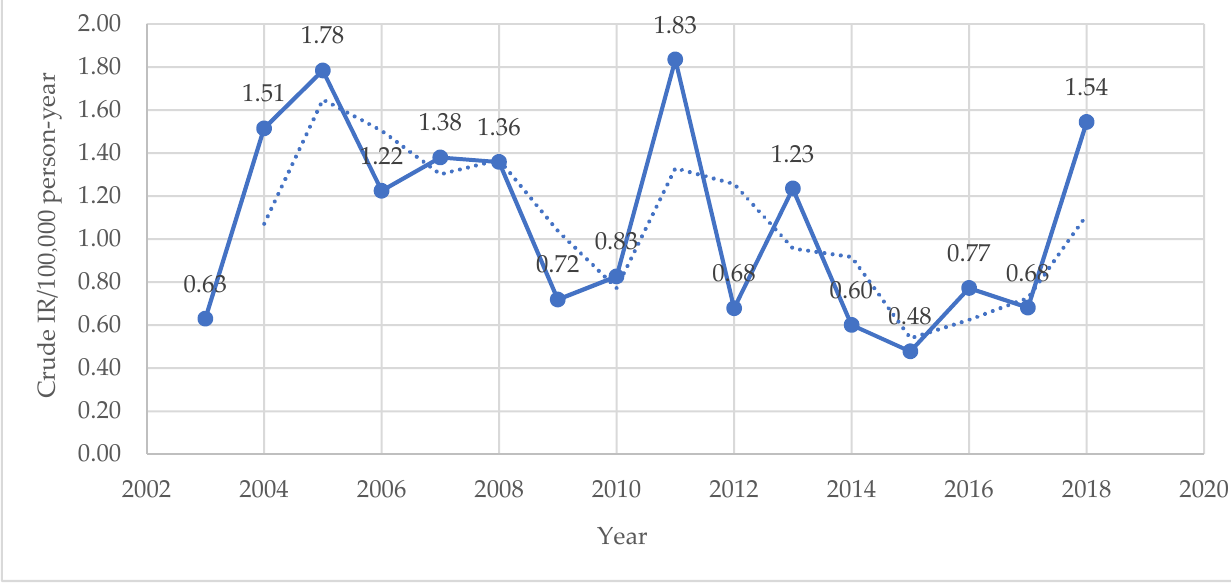
Figure 2. Distribution of ages at diagnosis, 2003–2018.